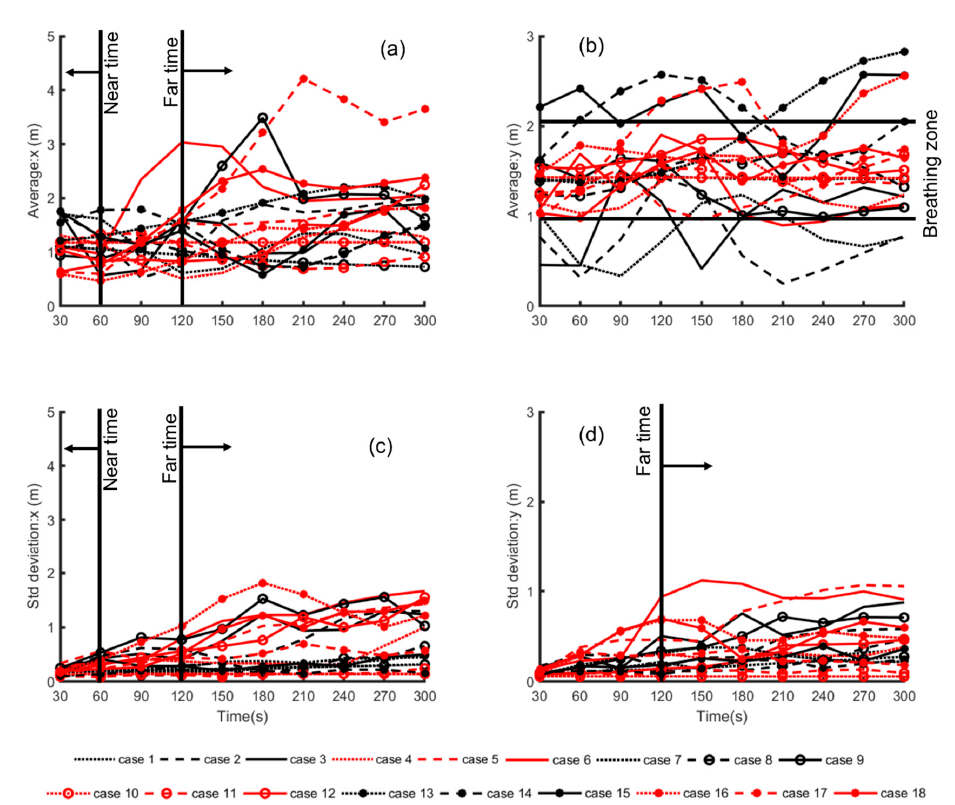
Figure 7. ( a ) Average x ; ( b ) average y ; ( c ) standard devaiton of x ; and ( d ) standard deviation of y for particle locations. Black = D wo /D wp = 1, red = D wo /D wp < 1; dotted lines: ACH = 3, dashed lines: ACH = 5, and solid lines: ACH = 7; no marker: h I /h o = 1, “o”: h I /h o >1 , and “*”: h I /h o < 1 .